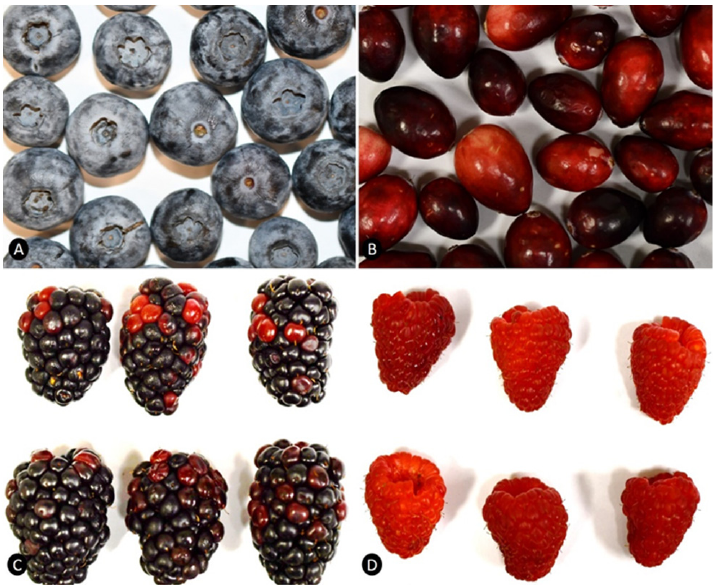
Figure 1. Types of berries. ( A ) berry ( Vaccinium myrtillus ). ( B ) False berry ( Vaccinium macrocarpon) . ( C , D ) Aggregate drupelets ( Rubus fruticosus ) and Rubus idaeus.